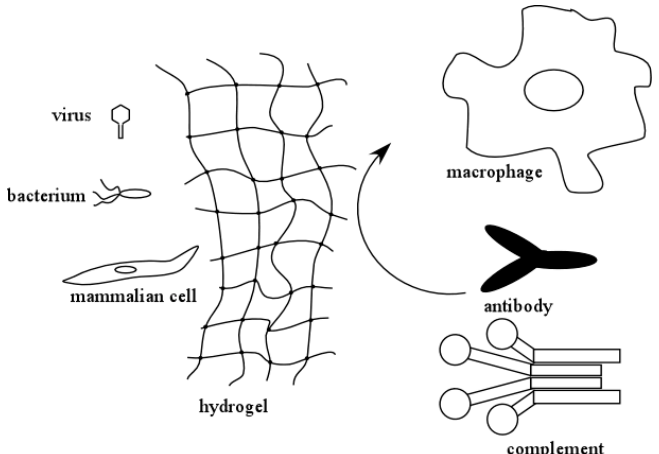
Figure 1. Hydrogels can present barriers that prevent recognition of encapsulated viruses, bacteria, or cells by the immune system. The hydrogel can also provide an internal environment that allows the encapsulated cells to survive changes in